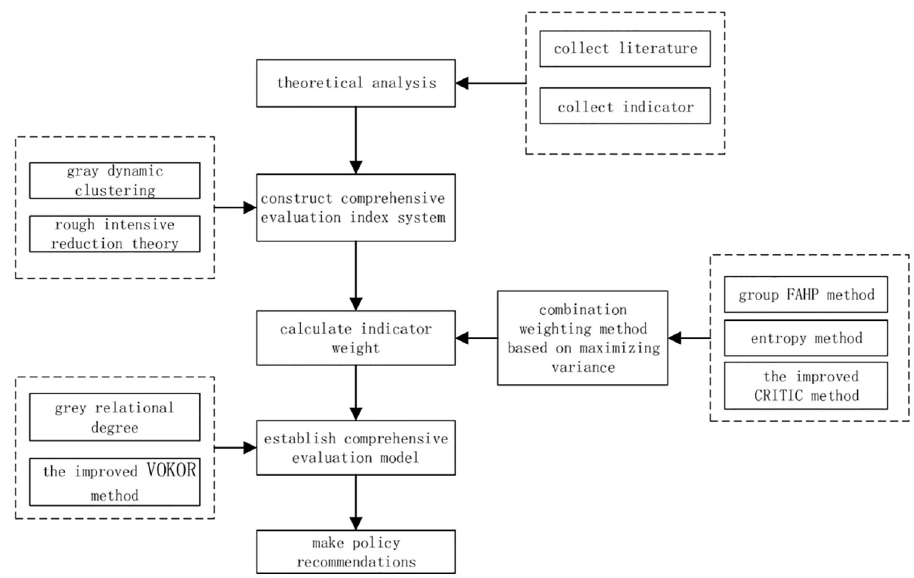
Fig 1. Full text implementation